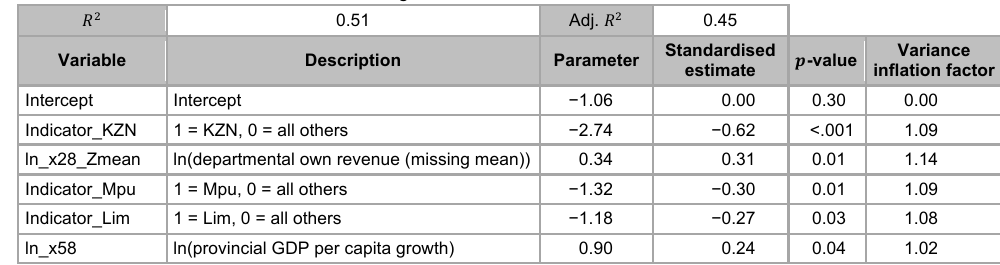
Linear-regression results of the HT data set